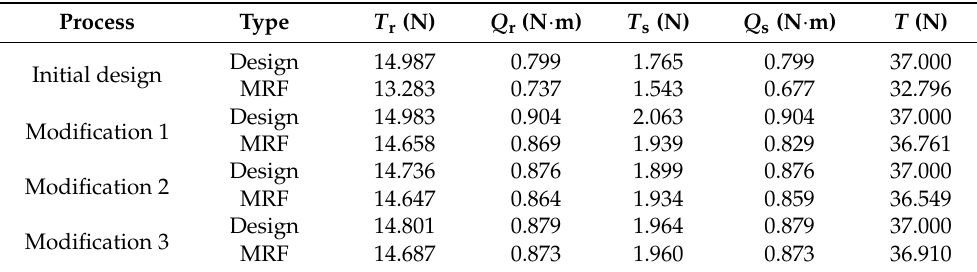
( b ) Figure 13. Design results of the chord length and torsion angle of the blade in the incoming flow state: ( a ) Rotor, ( b ) stator.